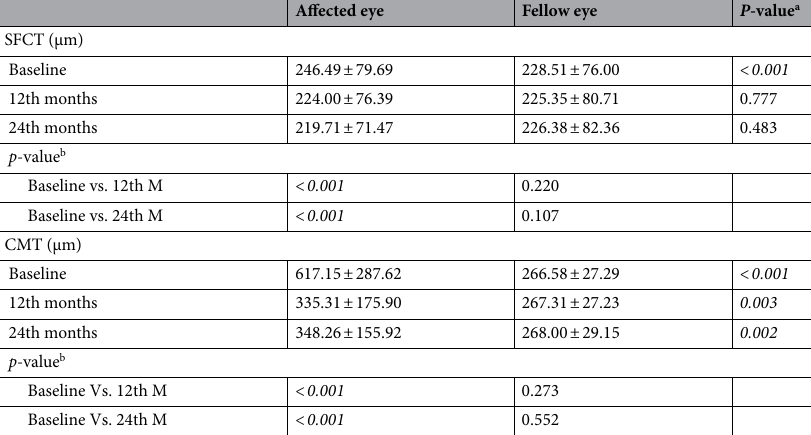
Comparison of subfoveal choroidal thickness between CRVO eyes and fellow eyes. In the CRVO eyes, baseline subfoveal choroidal thickness (SFCT) was significantly higher than in the fellow eyes (246.49 ± 79.69 vs. 228.51 ± 76.00, p < 0.001, Fig. 1). However, there was no significant difference between the two groups at 12 and 24 months (Table 3). In the CRVO eyes, SFCT decreased significantly at 12 and 24 months, compared to the baseline ( p < 0.001 for both periods). The fellow eyes did not showed a significant decrease in the SFCT at 12 and 24 months compared to the baseline ( p = 0.220 and p = 0.107, respectively; Table 3).